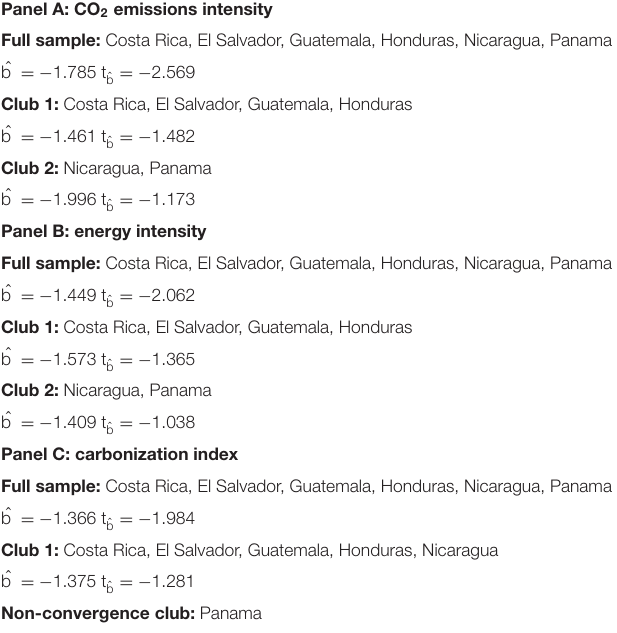
TABLE 2 | Club convergence results. Panel A: CO 2 emissions